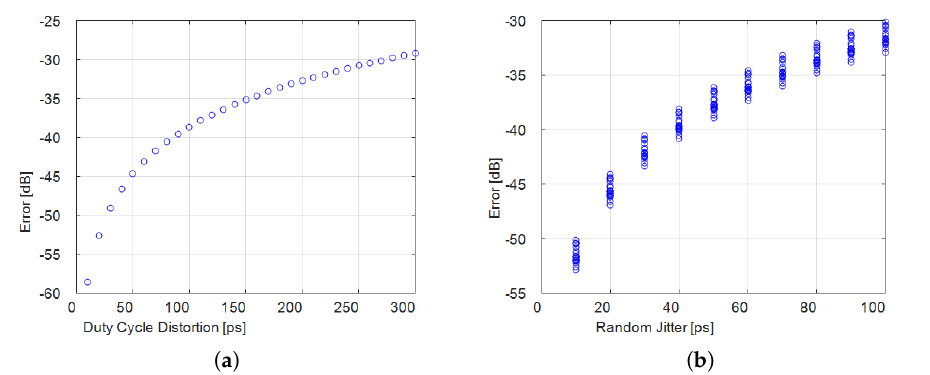
Figure 4. Numerical results of ME in the RD versus ( a ) Duty Cycle Distortion and ( b ) Random Jitter [43].